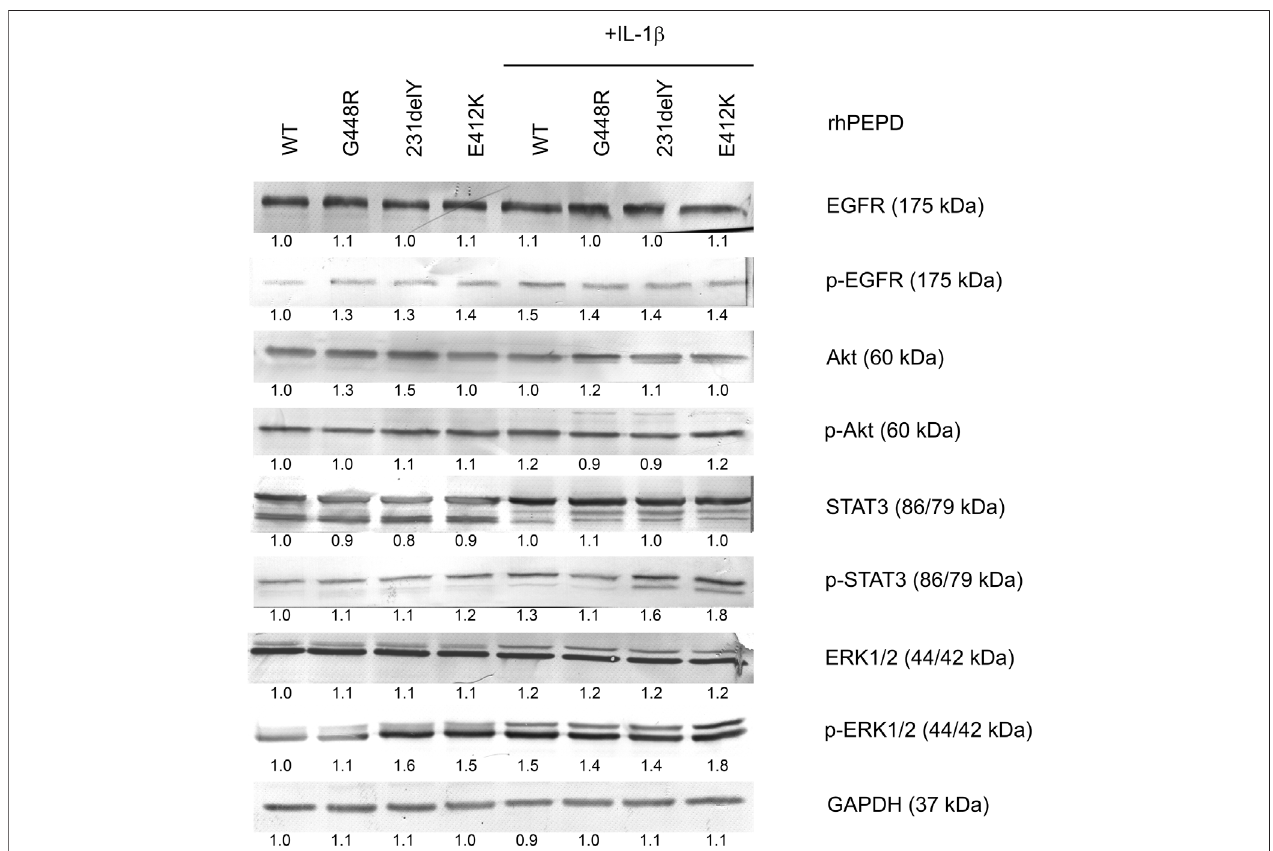
FIGURE5| TheeffectofrhPEPD WT andPEPDmutants(rhPEPD-G448R,rhPEPD-231delY,andrhPEPD-E412K)onEGFR-downstreamsignalingproteinsinIL-1 β treatedandnon-treatedHaCaTcells.GAPDHwasusedasaloadingcontrol.Thedataarepresentedasthemean±SD, n =3ineachgroupandcomparedtothecontrol group. Representative blot images were shown (densitometry of protein stains is presented under protein bands as a ratio versus control; Supplementary Figure S1